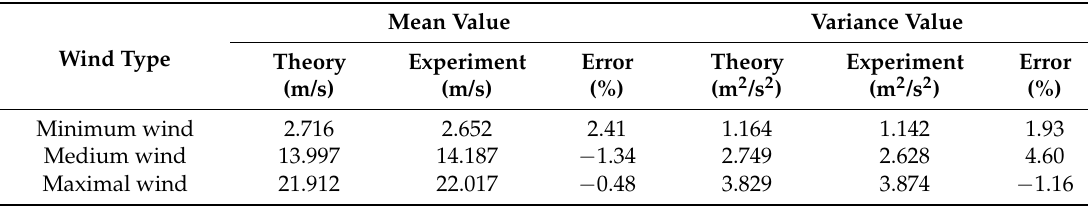
Table 3. Comparison of mean and variance value of random wind velocity.